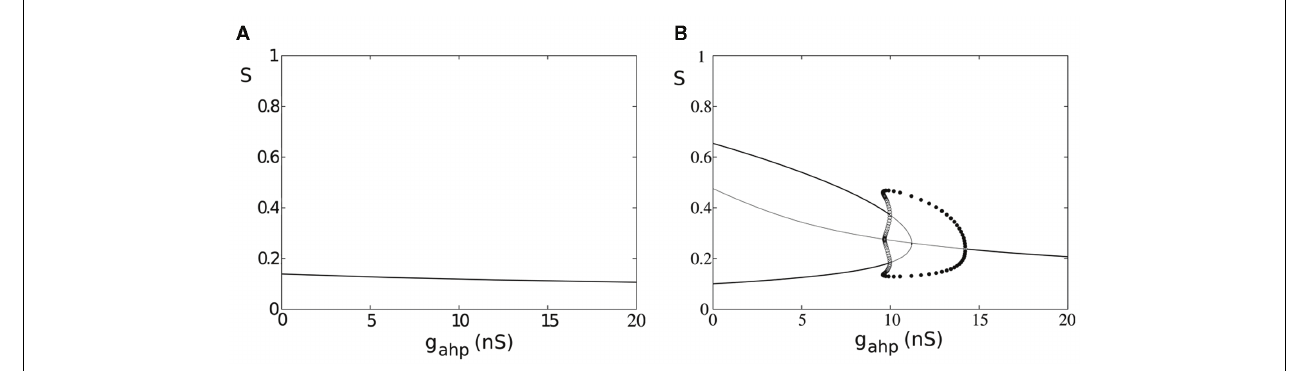
thin lines. Filled circles are the maximum and the minimum amplitudes of stable oscillations. Open circles correspond to unstable oscillations. (B) Bifurcation diagram in the presence of stimulus λ 1 = λ 2 =